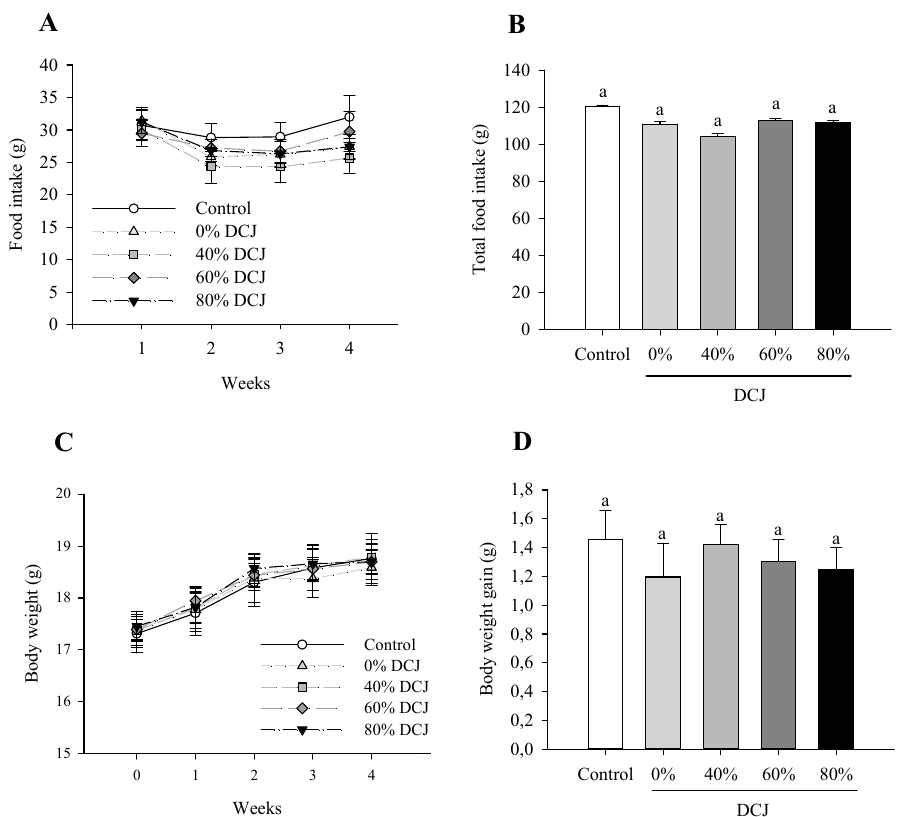
Figure 1. Effect of the deacidification of CJ on the ( A ) food intake, ( B ) total food intake, ( C ) body weight, and ( D ) total body weight gain in mice in comparison with a control (water). Results are presented as the mean ± SEM and n = 8 for A and B and n = 12 for C and D . ANOVAs combined with a Tukey’s test were done on A – D . For ( A , C ), the absence of letter means that there is no statistically significant effect at a probability level of 0.05. For ( B , D ), a different letter means that the results are significantly different at a probability level of